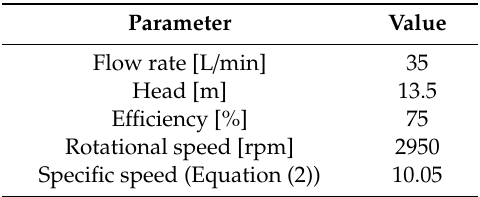
Table 3. Best e ffi ciency point in the pumping